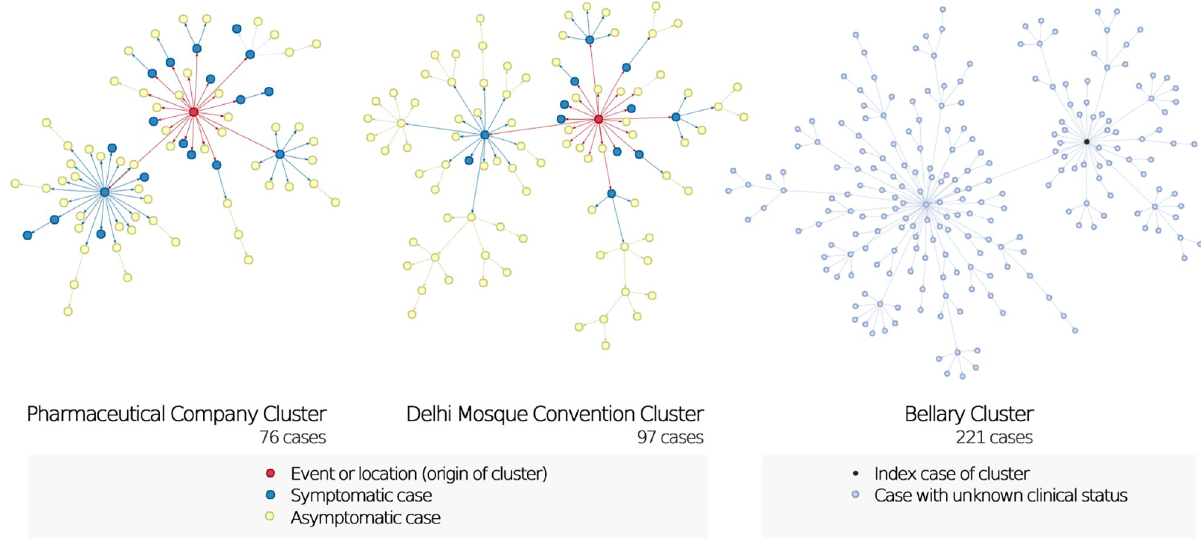
Fig 2. Transmission networks of three largest clusters of SARS-CoV-2 cases in Karnataka, India up to 21 July 2020. The networks indicate the heterogeneity in transmission from infected cases, with a few patients causing most secondary cases. The Bellary cluster occurred in June and July, during which symptomatic status of cases was not